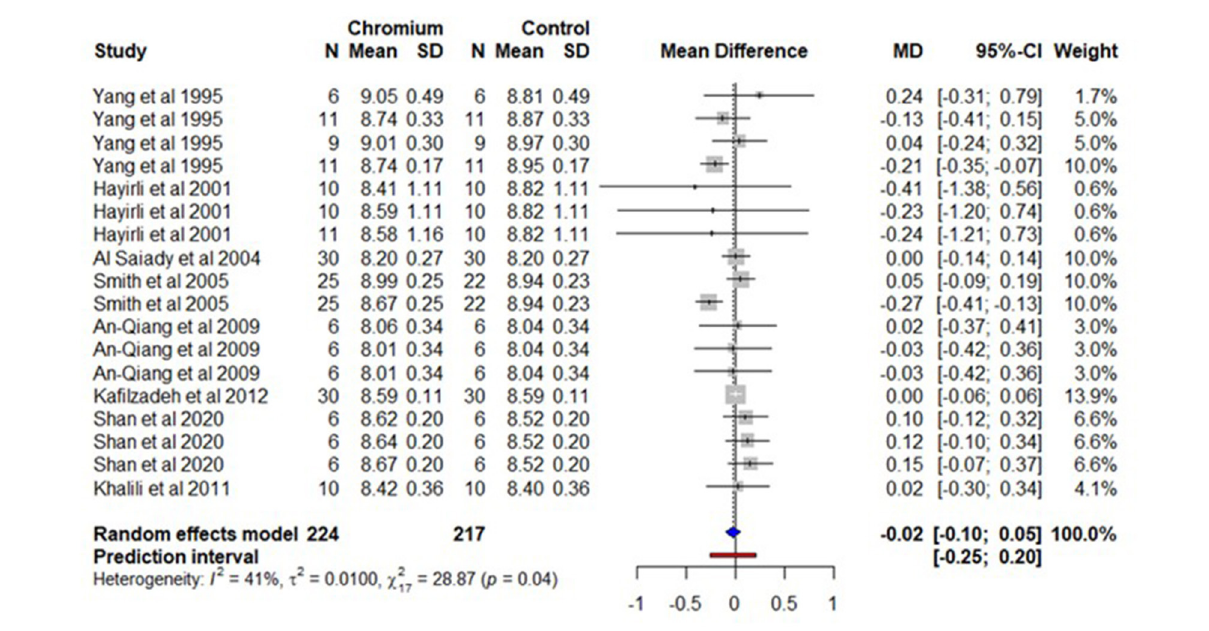
FIGURE7 The forest plot of the random-effect meta-analysis for solid-not-fat content. The effect size was calculated as the mean difference (MD), and the solid vertical line represents the line of no effect or zero line. The dotted vertical line represents the average effect size for solid-not-fat content in cows supplemented with chromium. The negative value under the MD heading indicates a decrease in solid-not-fat content and vice versa. The black horizontal line represents the confidence interval for each study and the gray square represents weight or effect size of the corresponding study. The blue diamond represents the average effect size of the